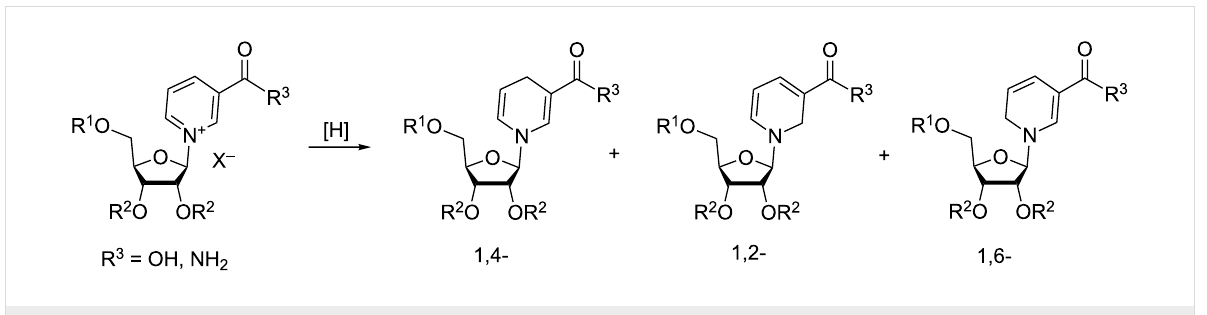
Figure 5: Reduction of derivatives of NR + X ˉ into corresponding 1,2-; 1,4-; 1,6-NRH derivatives.